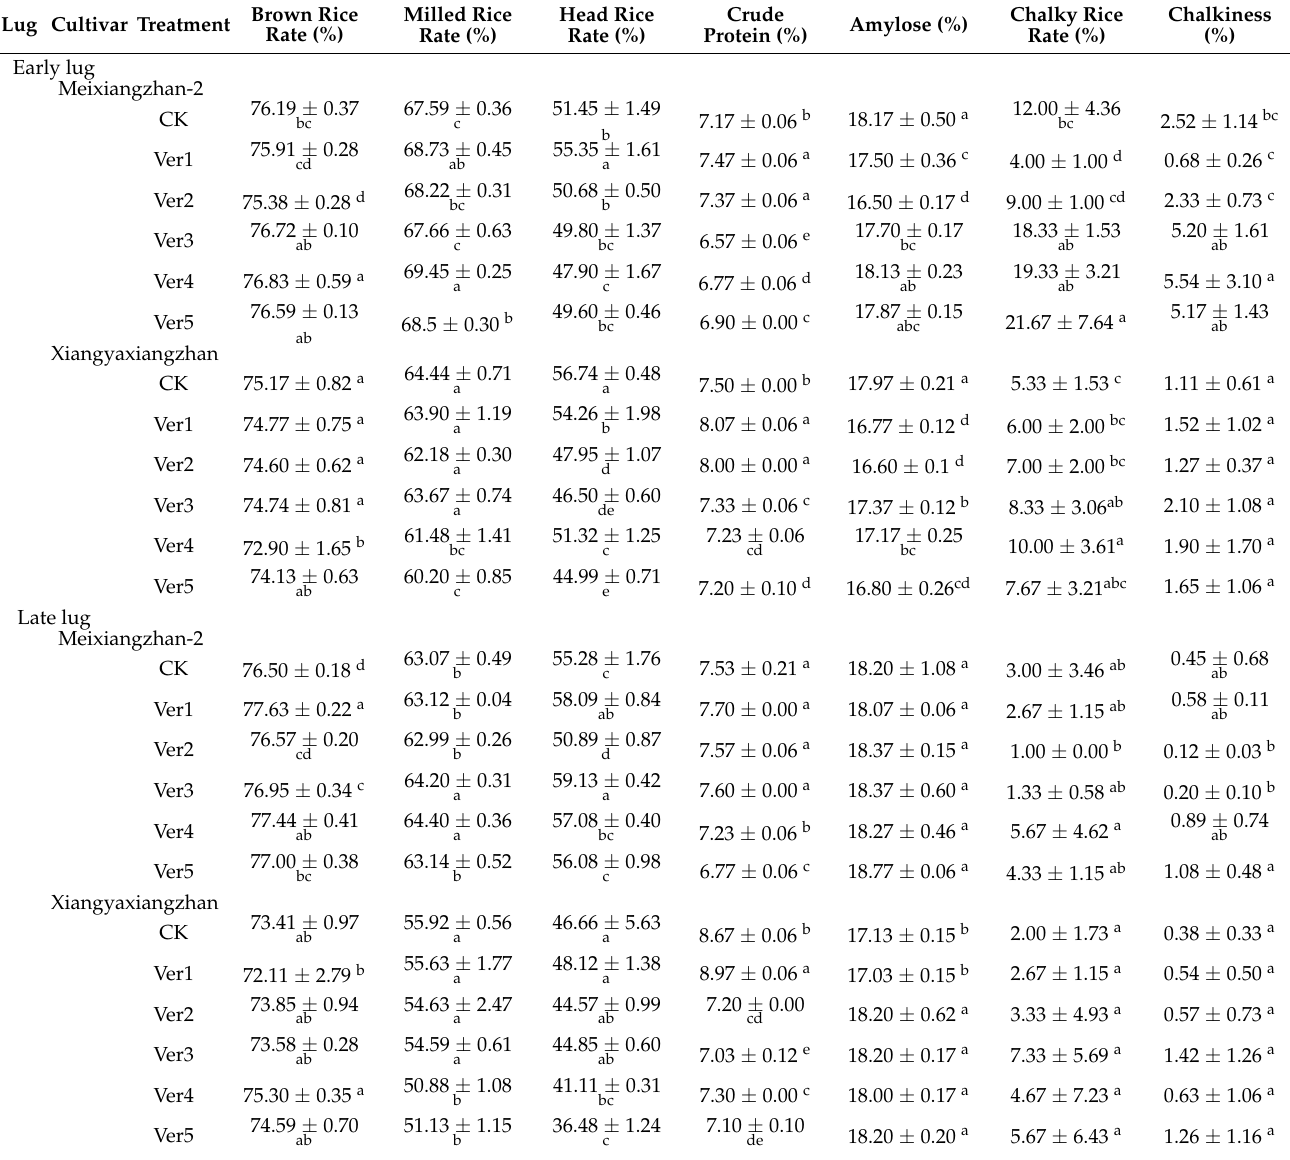
Lug Cultivar Treatment